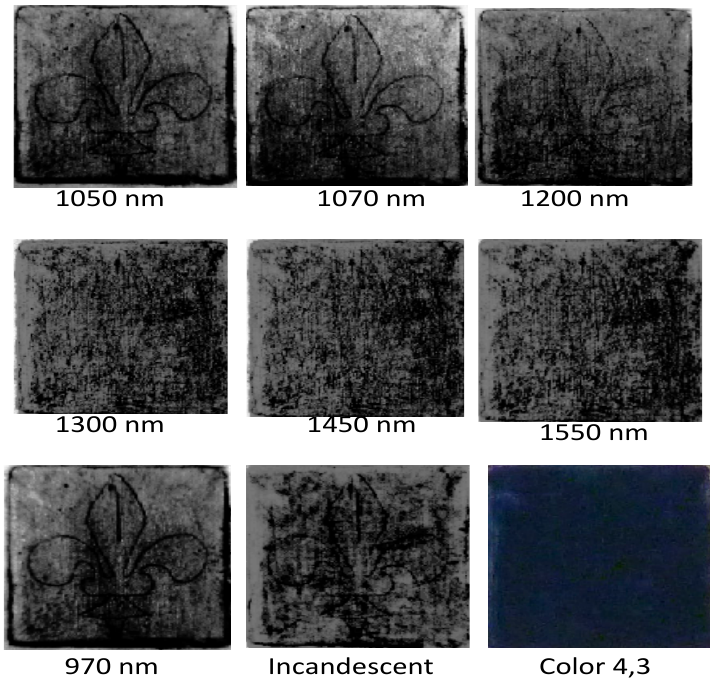
Figure 5. Multispectral imaging of the Color pixel 4,3 (lower right corner) indicates dark blue color observed in the visible. Different degrees of transparency are indicated when this pixel is illuminated with the IR radiation. The central wavelength in nm of the illuminating lamp is indicated below the sample, ranging from 1050 to 970 nm. The best quality of the underline image is obtained with illumination at 970 nm. The image quality decreases with increasing